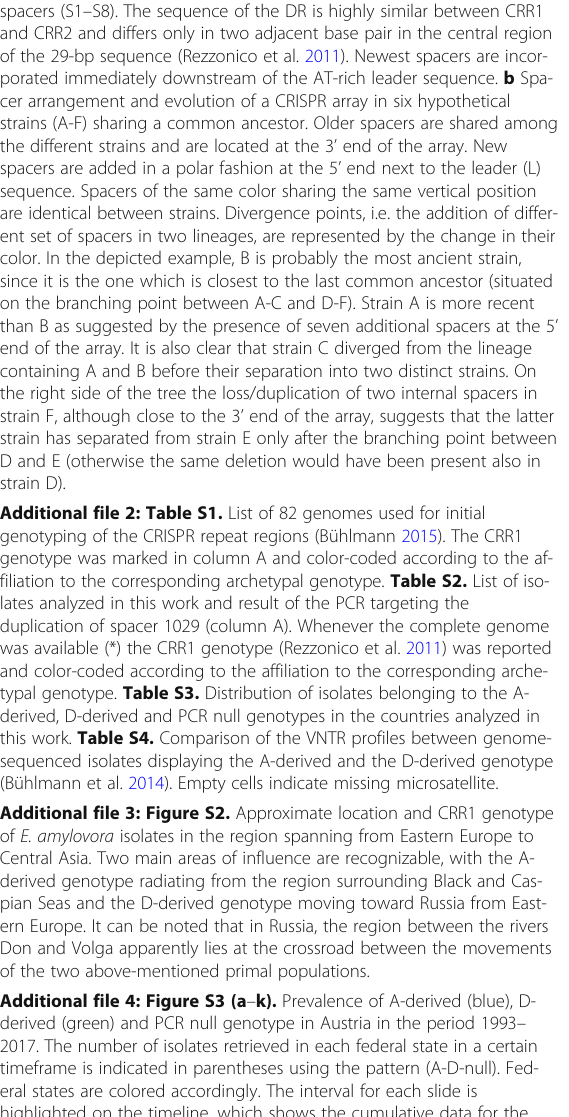
Additional file 1: Figure S1. a Schematic structure of CRR1 and CRR2 in E. amylovora . The CRR is constituted of an AT-rich leader sequence